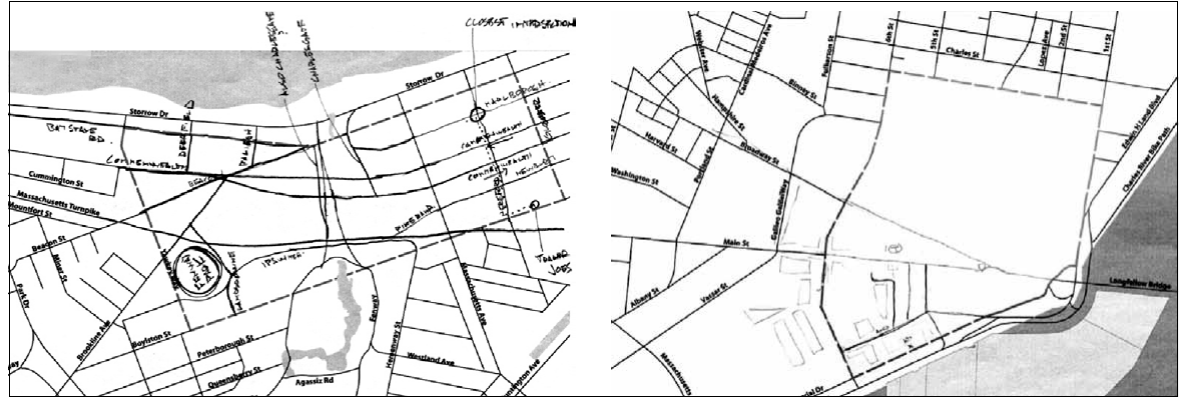
fig. 3. Sample of survey result in Kenmore and Kendall